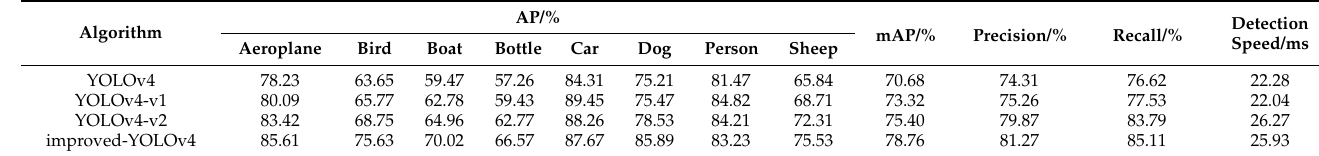
Table 2. Small target detection performance index of the VOC2007 data set.